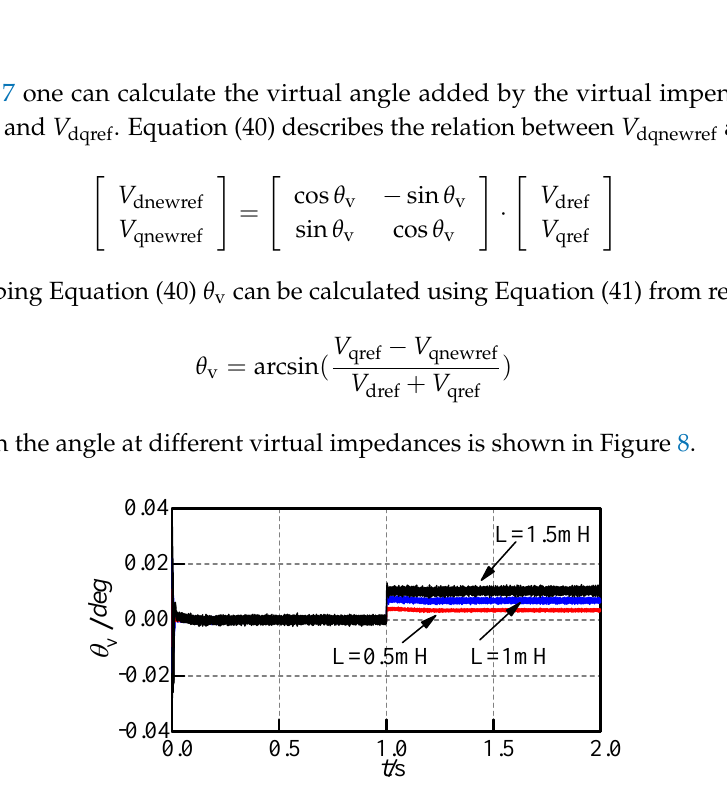
Figure 8. The change of angle at different virtual impedances.